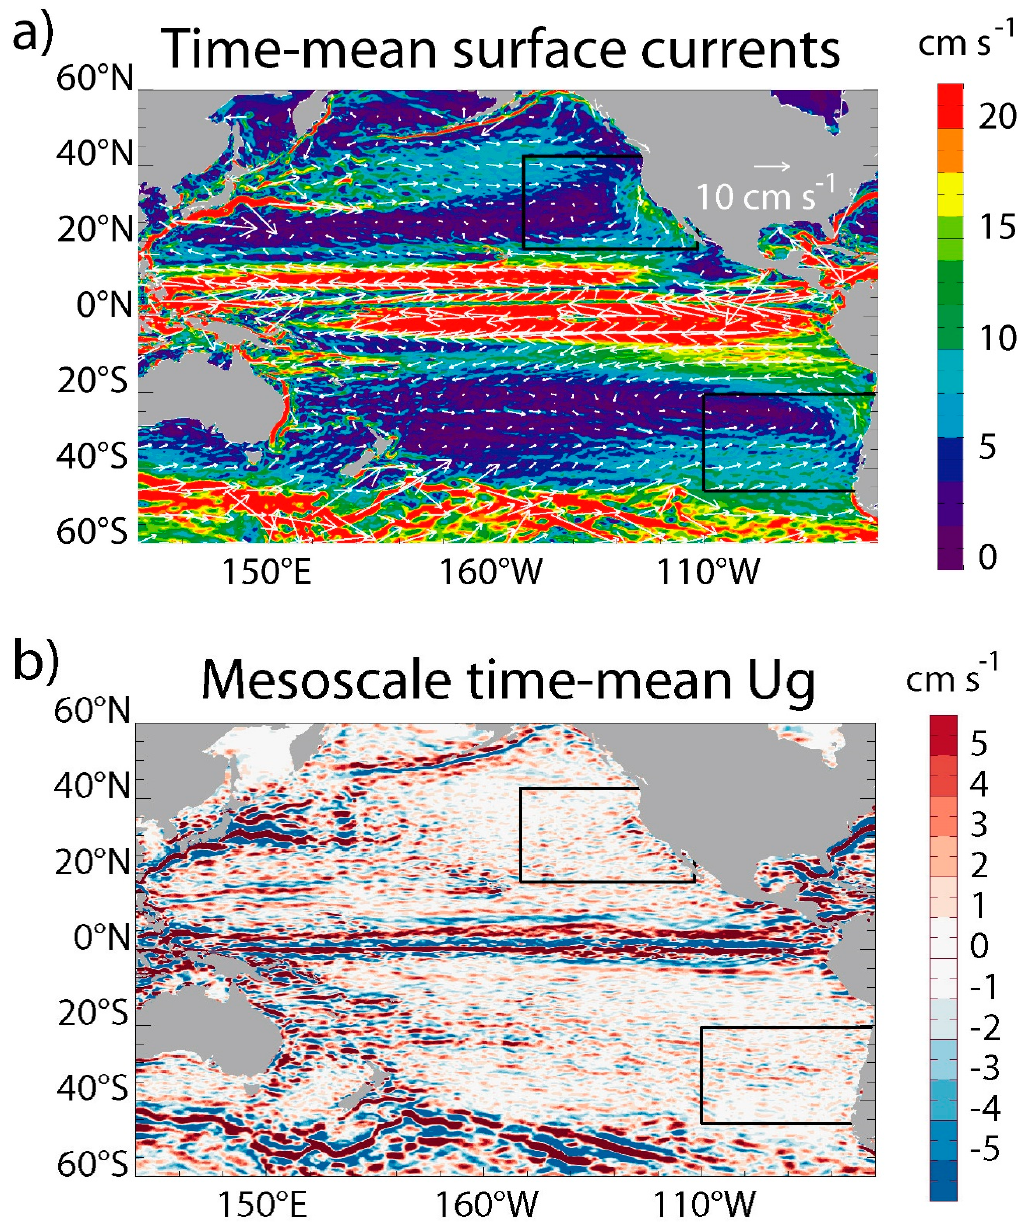
Figure 1. Surface circulation and quasi-zonal jets in the Pacific Ocean: ( a ) GlobCurrent surface current velocity (shading, cm s − 1 ) and vectors, and ( b ) SSALTO/DUACS spatially high-pass filtered zonal geostrophic velocity U g , averaged over 2 July 2012–31 December 2018 (see Section 2 for a detailed description of the data and filtering method). The black boxes outline the two study regions off the Californian and Chilean EBUS in the subtropical North and South Pacific, respectively.